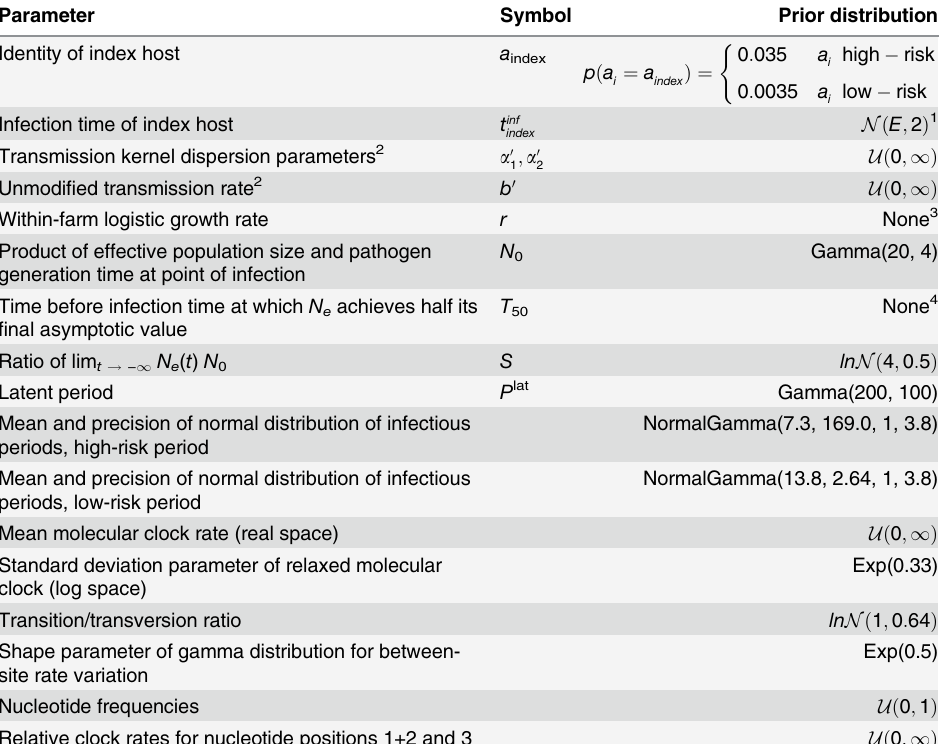
Table 3. Parameters used in the H7N7 analysis, and prior distributions for their values. Parameter Symbol Prior distribution Identity of index host a